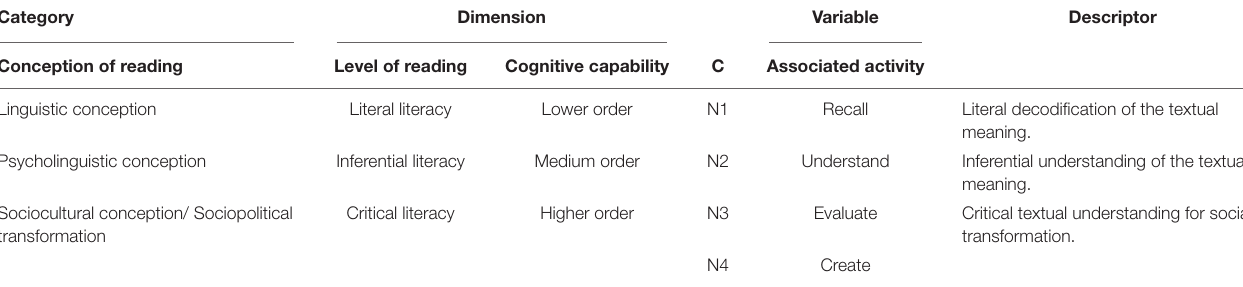
TABLE 2 | Progressive levels of cognitive-reading.